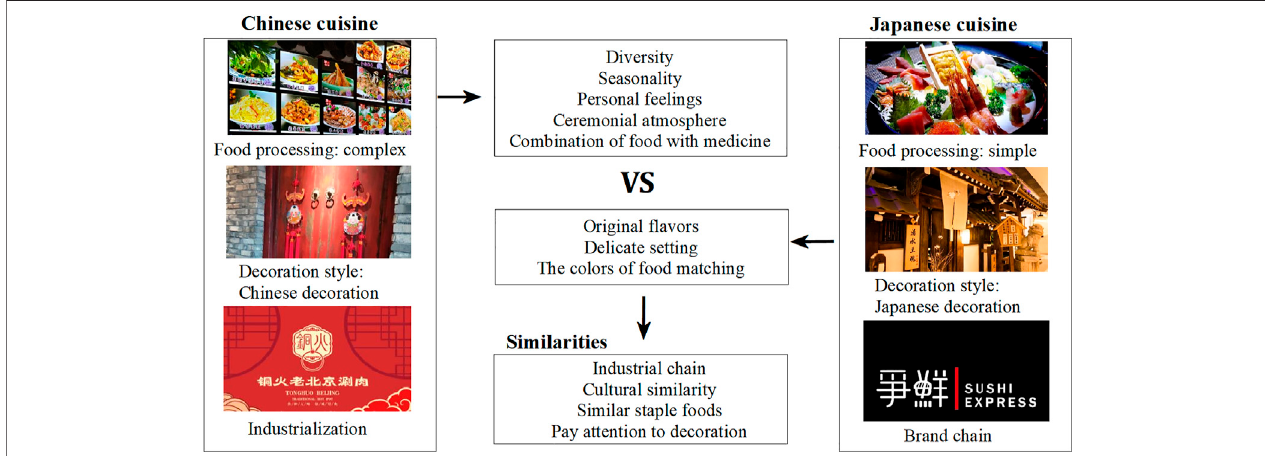
FIGURE 5 | Similarities between Japanese cuisine and a traditional Chinese